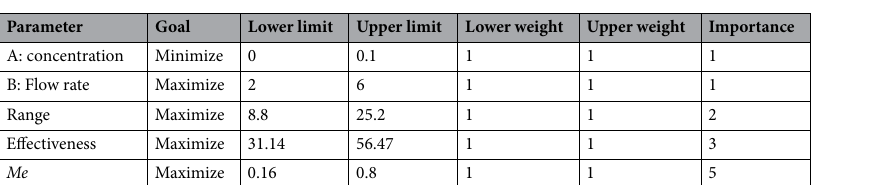
Table 15. The optimization conditions of MWCNTs and TiO 2